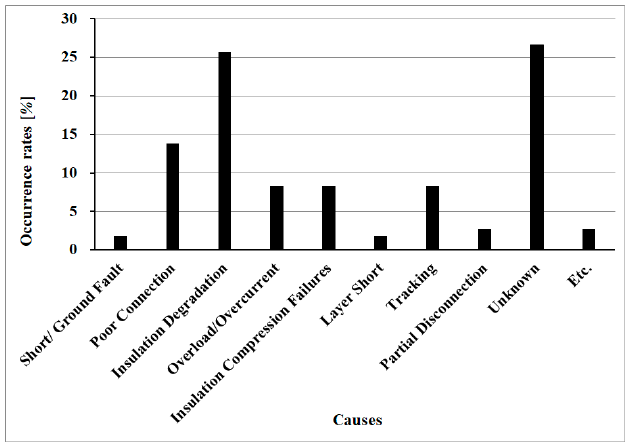
Figure 1. Occurrence rates of electrical fire causes in Korea (2017~2019).